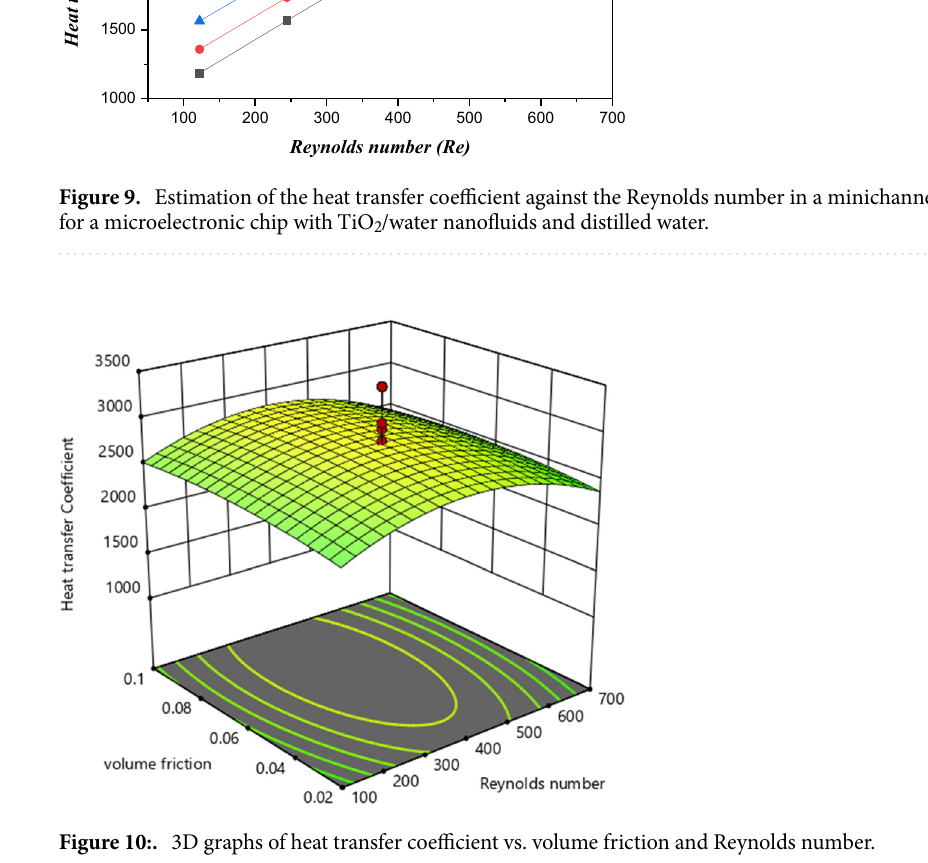
Figure 10:. 3D graphs of heat transfer coefficient vs. volume friction and Reynolds